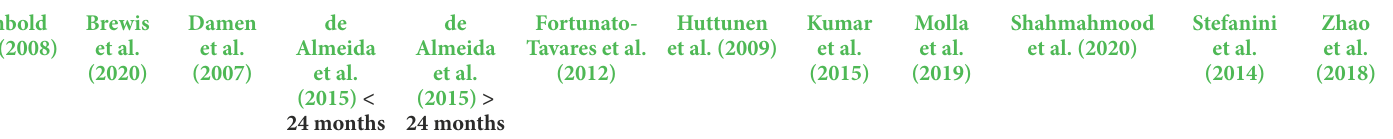
TABLE 8 Education subscale Tukey HSD post-hoc mean